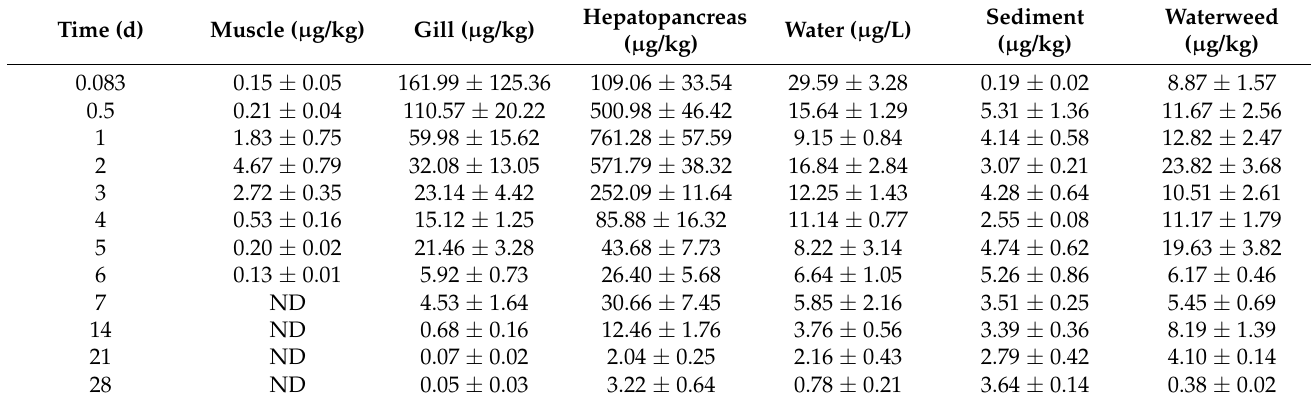
Table 7. Pendimethalin quantification in test ponds sprayed with the 50% recommended dose (0.14 mg/L).